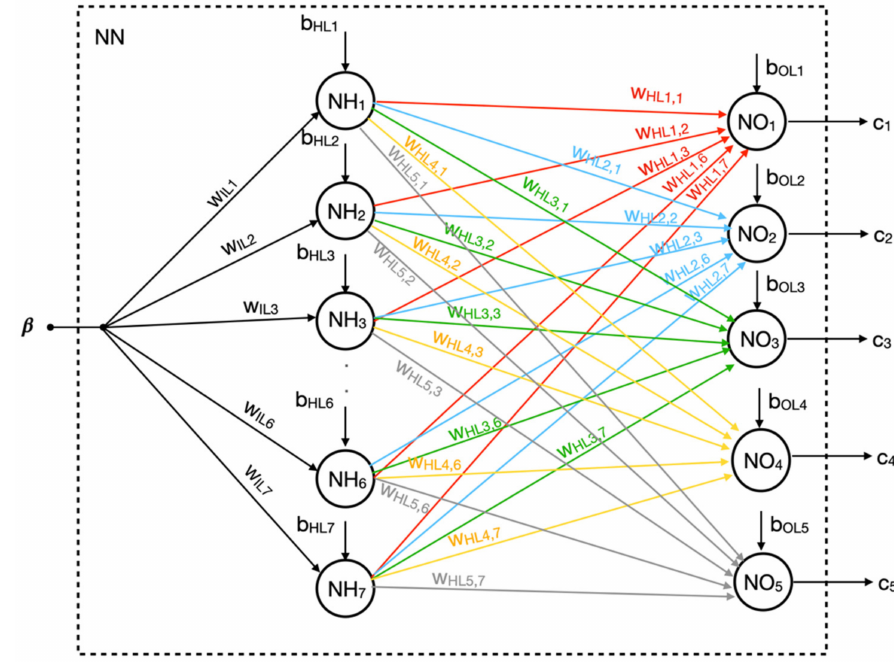
Figure 7. The general structure of the four neural